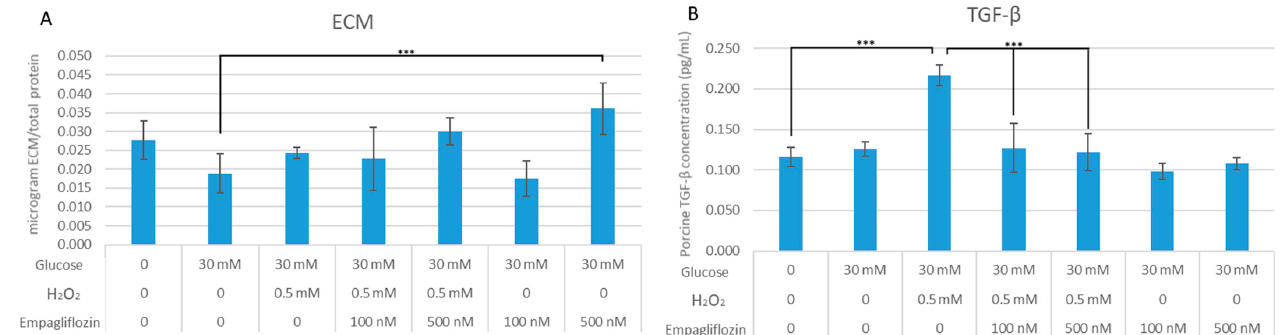
Figure 2. ( A ) Effects of empagliflozin on collagen synthesis in LLC-PK1 cell line. One-way ANOVA F(8,79) = 4.337, p = 2.571 × 10 − 2 , and Tukey HSD post hoc test, *** p < 0.001. Values are expressed in micrograms ECM per total protein as mean with standard deviation ± SD. Values below the x -axis indicate compound quantity. ( B ) Effects of empagliflozin on TGF- β 1 concentrations in LLC-PK1 cell line. One-way ANOVA F(7,23) = 14.54, p = 7.47 × 10 − 6 , and Tukey HSD post hoc test; *** p < 0.001. Values are expressed in picograms per millilitre as mean with standard deviation ± SD. Values below the x -axis indicate the quantity of compounds.